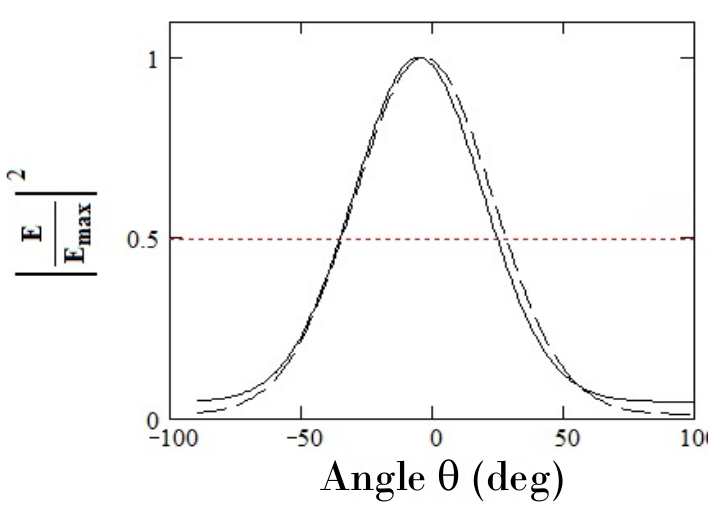
Figure 12. Radiation patterns of L -range antennas made from metal (solid line) and fiber (dashed line). E max is the maximum value of the field amplitude.